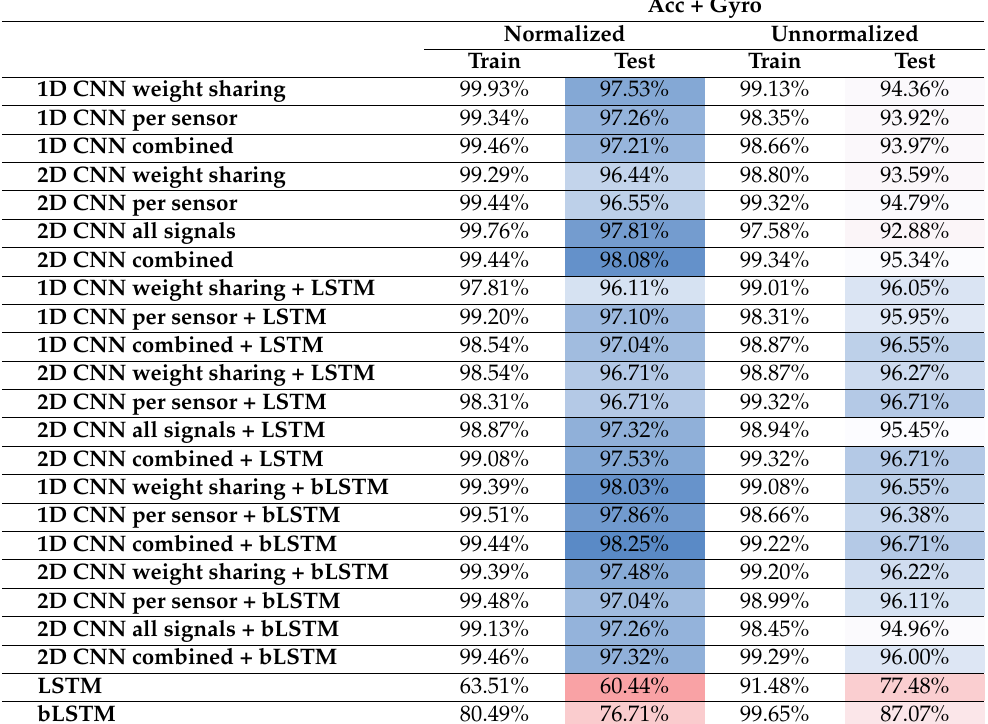
Table 3. Comparison of mean prediction accuracies between the original unnormalized models and the normalized ones. Five runs. A red-to-blue color code is used to facilitate the visualization of the values on the test dataset, where red is worse and blue is